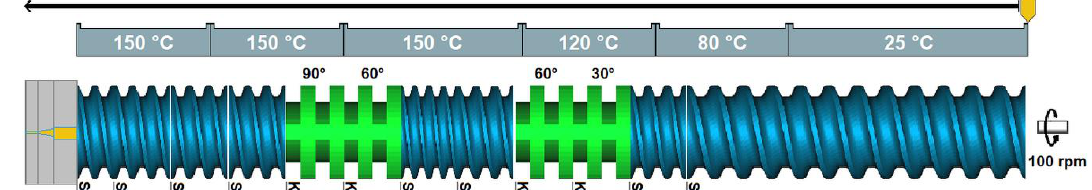
Figure 1. Extruder and screw configuration used with conveying elements (9, 12, and 18 mm pitch) (blue) and kneading elements (30°, 60°, and 90° staggering angle) (green). Reproduced with permission from the authors of [21], Elsevier B.V., 2017.